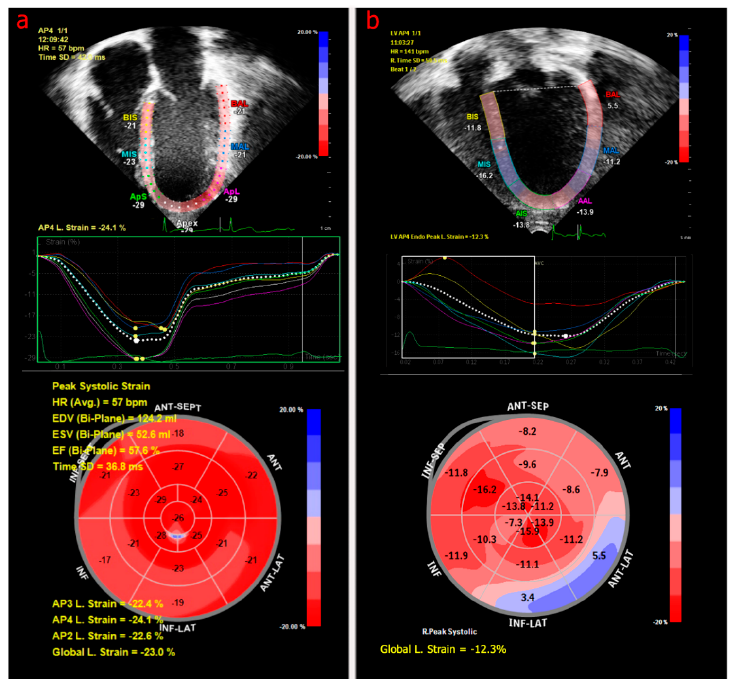
Figure 1. Apical four-chamber speckle-tracking images measuring left ventricular strain in asymptomatic pediatric patients who underwent chemotherapy with normal strain ( a ) and abnormal strain ( b ). In the middle panels, the colored lines correlate with 2D segments of the LV and the dotted line represents the average strain. The lower panel summarizes the global longitudinal strain in a bullseye plot, with blue representing dyskinetic segments in patient ( b ) with abnormal strain.